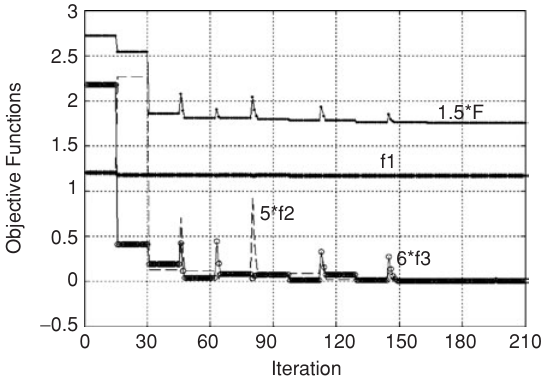
Figure 12 Evolution of the objective function and optimality criteria versus number of iterations for the numerical example.